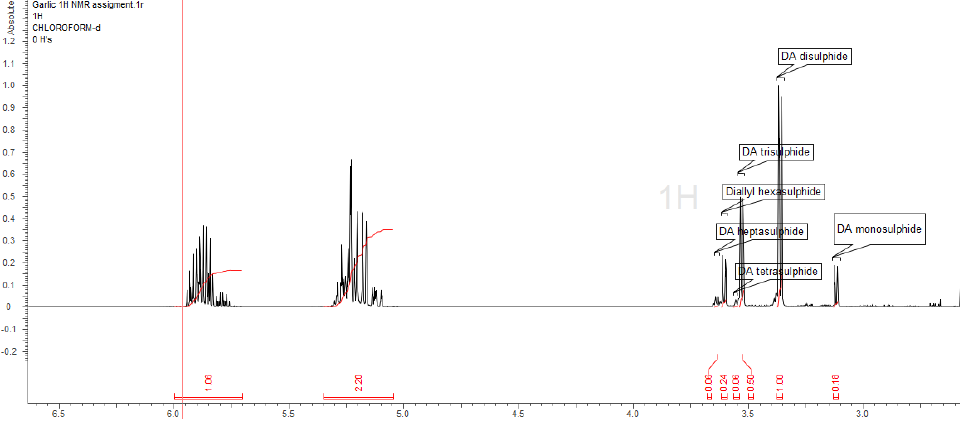
Figure 1. Garlic essential oil 1 H NMR spectrum.